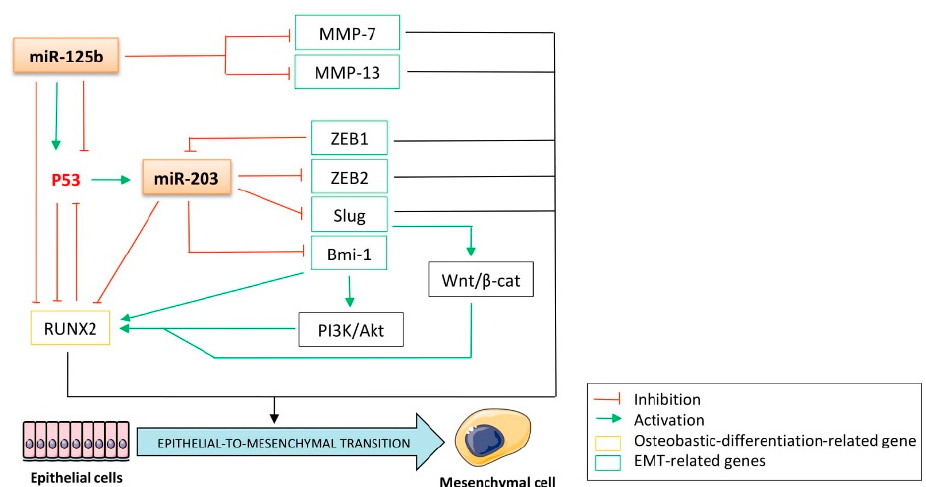
Figure 8. The p53-related miRNAs’ interplay between the epithelial-to-mesenchymal transition (EMT) and the osteoblastic-differentiation. β -cat : β -catenin; EMT : epithelial-to-mesenchymal transition; MMP : matrix metalloproteinase; MMP-7 : matrix metalloproteinase 7; MMP-13 : matrix metalloproteinase 13; PI3K : phosphoinositide 3 kinase; RUNX2 : runt-related transcription factor 2.